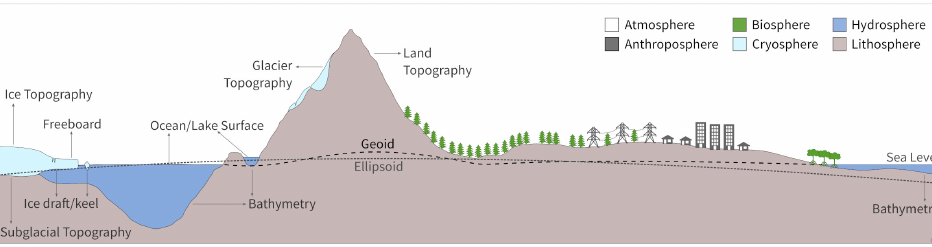
ideally assigned a unique European Petroleum Survey Group (EPSG) code. The horizontal